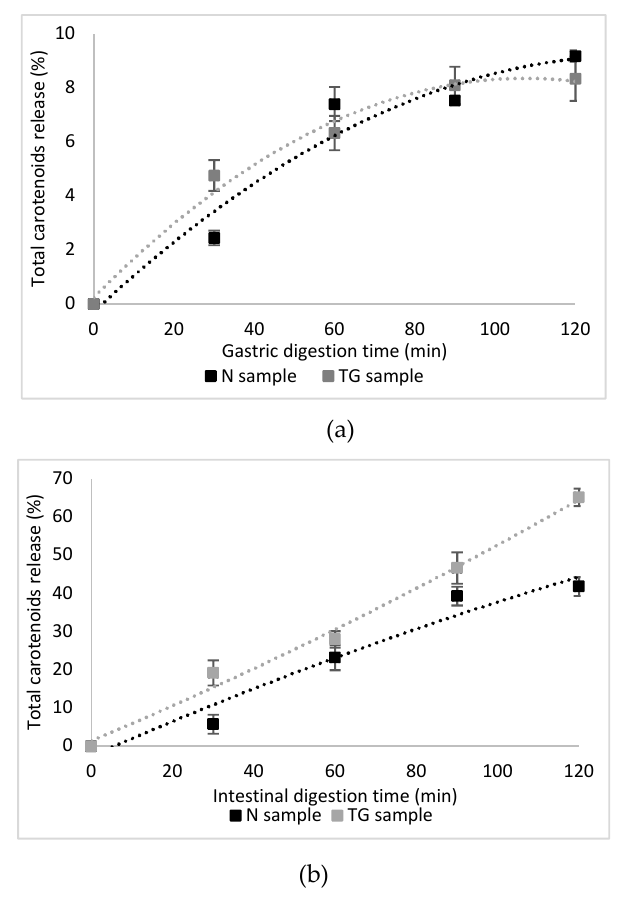
Figure 1. In vitro digestion of total carotenoids in simulated gastric ( a ) and intestinal ( b ) juices.